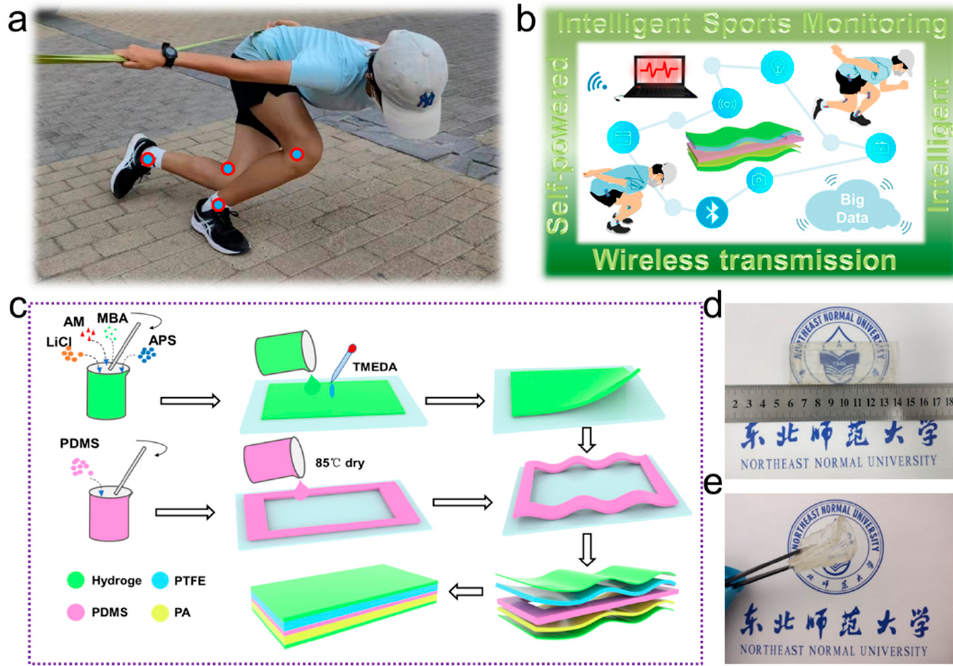
Figure 1. Application scenarios and production process of SD-TENG. ( a ) Application of SD-TENG in speed skating land training. ( b ) Application of SD-TENG in smart sports monitoring. ( c ) The fabrication process of SD-TENG. ( d ) The optical photograph of SD-TENG. ( e ) The photograph of SD-TENG’s flexible